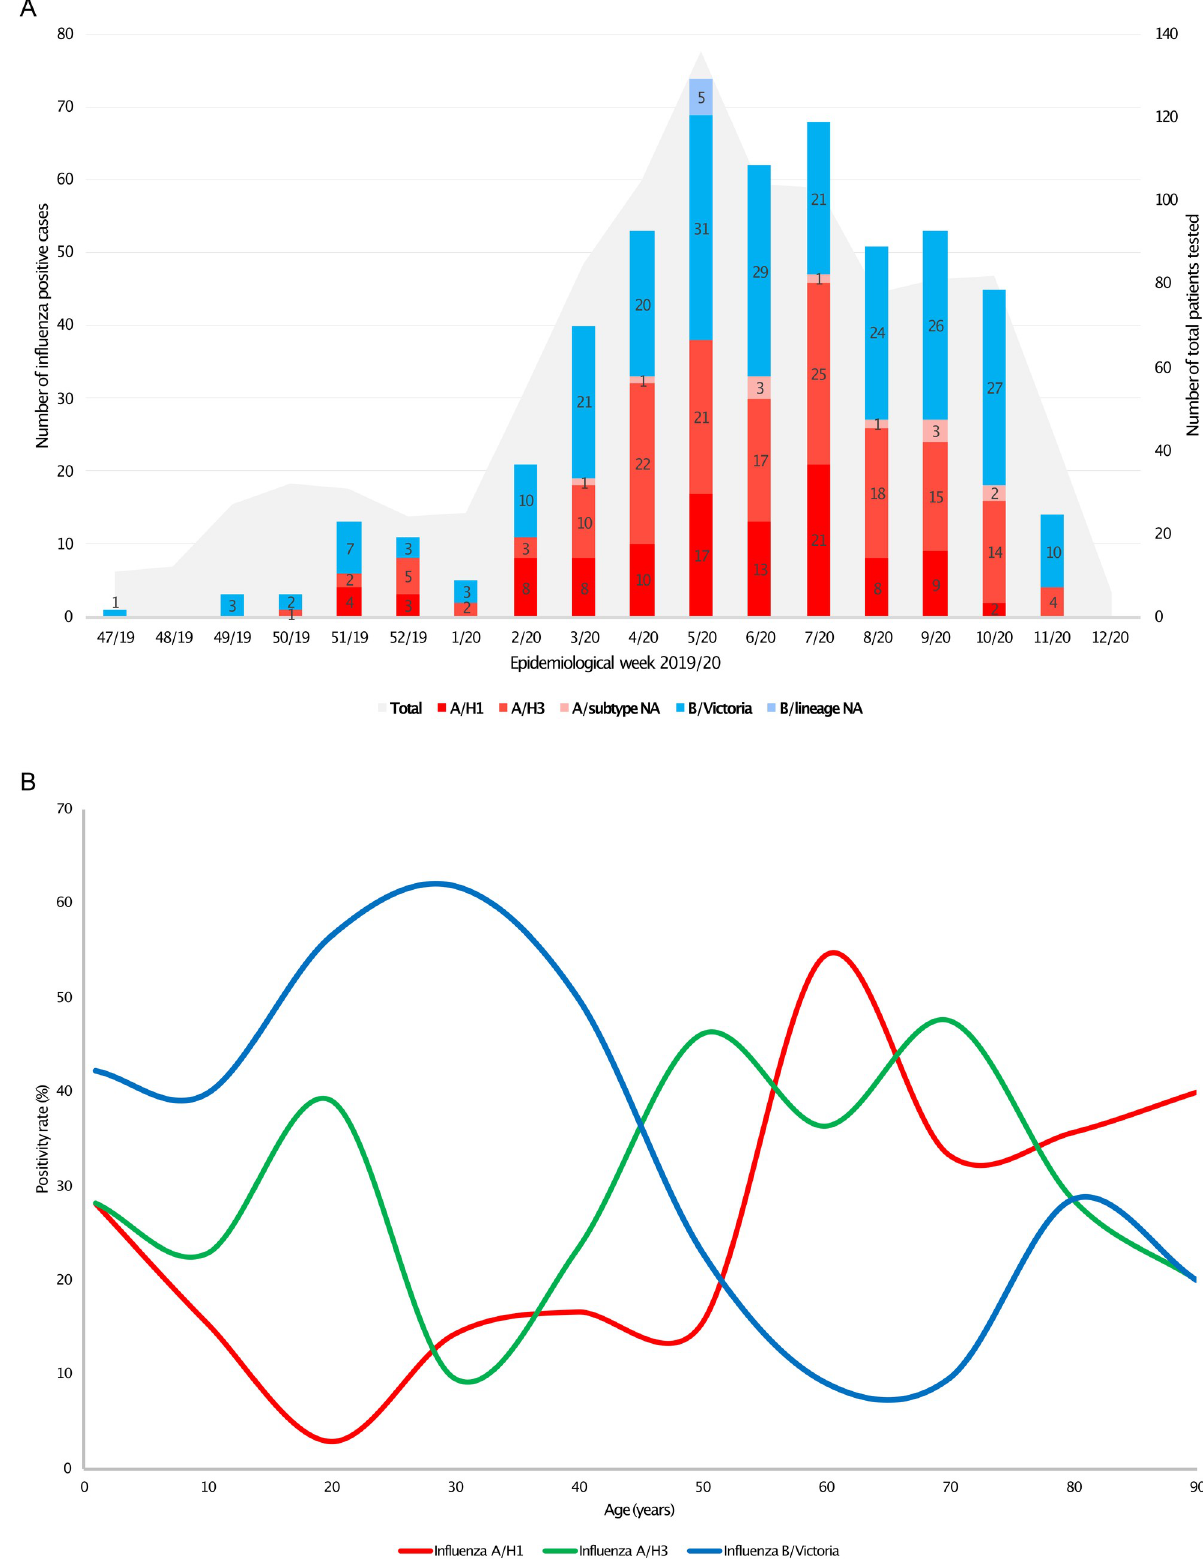
Fig 2. A . Weekly distribution of influenza positive cases by viral types, subtypes/lineages during the influenza season 2019/20. B. Distribution of attack rates for different influenza types, by patient age. Data is expressed as percentage of the laboratory-confirmed influenza cases.